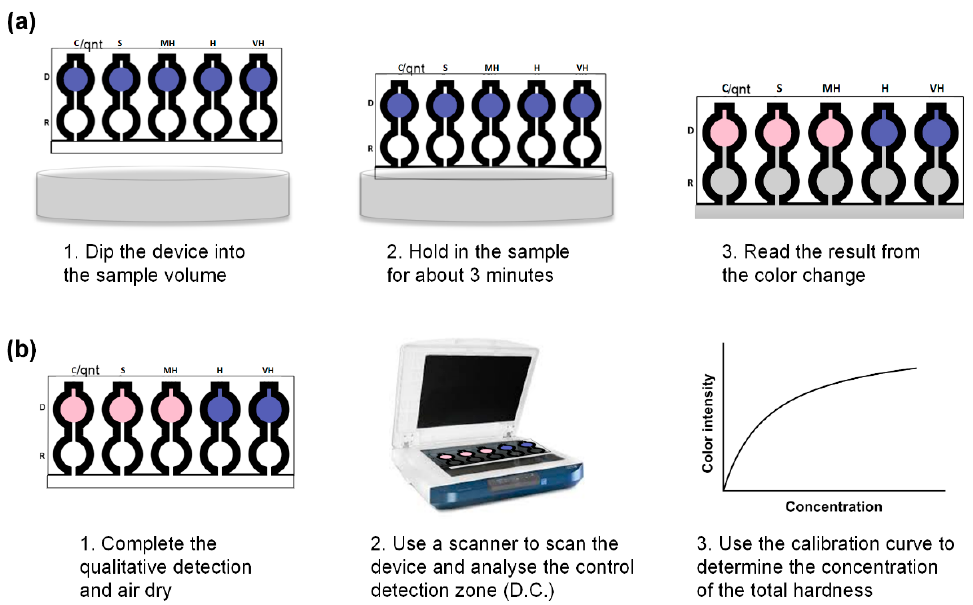
Figure 5. The application of the paper-based analytical device for water analysis. ( a ) Qualitative detection of total hardness using a lateral flow dip-and-read paper based analytical device. ( b ) Quantitative detection of total hardness using a lateral flow dip-and-read paper based analytical device.